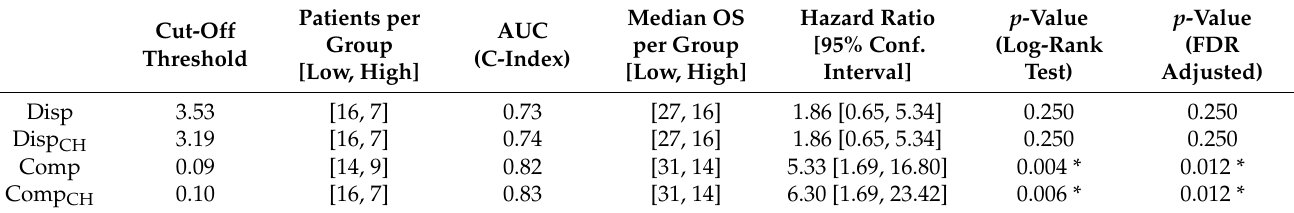
Table 2. Results of the log-rank test of the Kaplan–Meier analysis. For each biomarker, the median OS and number of patients with high and low biomarker value are presented. Additionally, differences between OS (months), hazard ratios, area under the curve (AUC), and log-rank test resulting p -value are presented. * Indicates significant difference ( p <